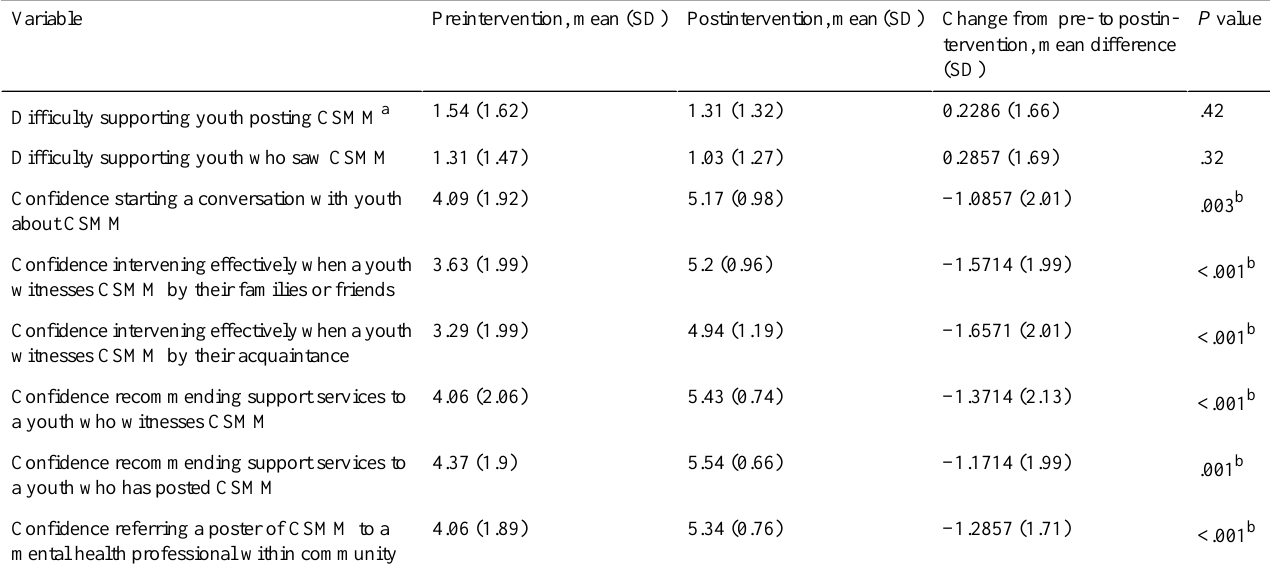
Table 3. Comparison of training effectiveness between pre- versus postintervention.